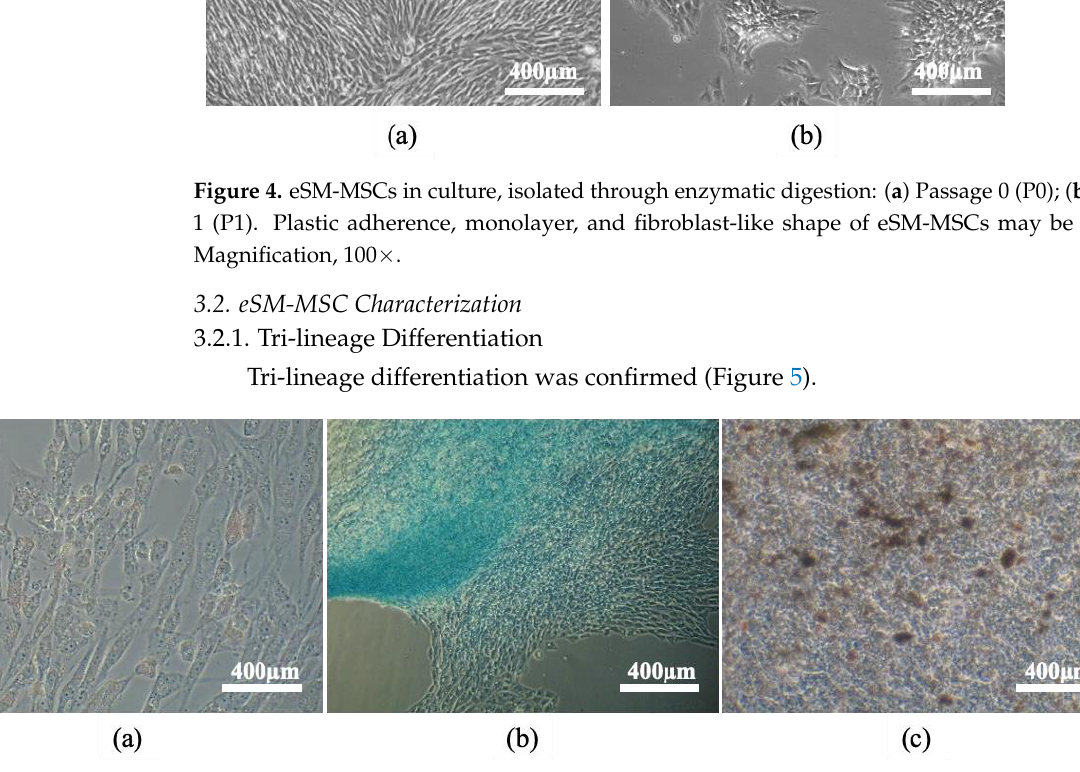
Figure 5. Tri-lineage differentiation: ( a ) eSM-MSC’s adipogenic differentiation, cytoplasmatic lipid vacuoles stained in red (Oil red staining); ( b ) eSM-MSC’s chondrogenic differentiation, proteoglycans in extracellular matrix stained in blue (Alcian blue staining); ( c ) eSM-MSC’s osteogenic differentiation, extracellular calcium deposits stained in red (alizarin red staining). Magnification 100×.